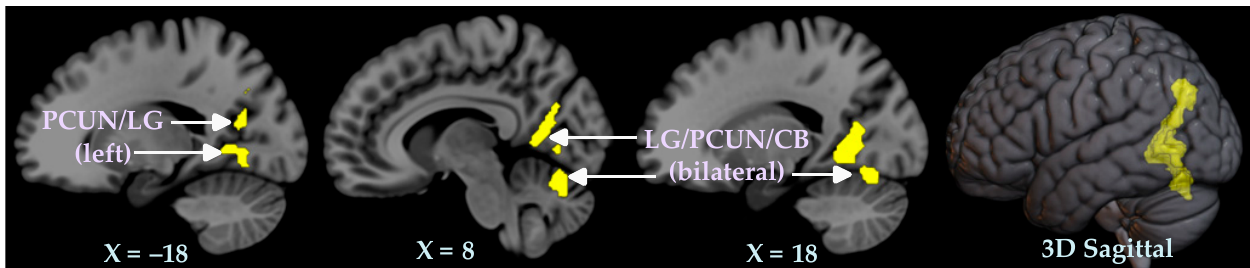
Figure 3. Whole-brain meta-analyses of studies comparing individuals with tinnitus and ( A ) normal